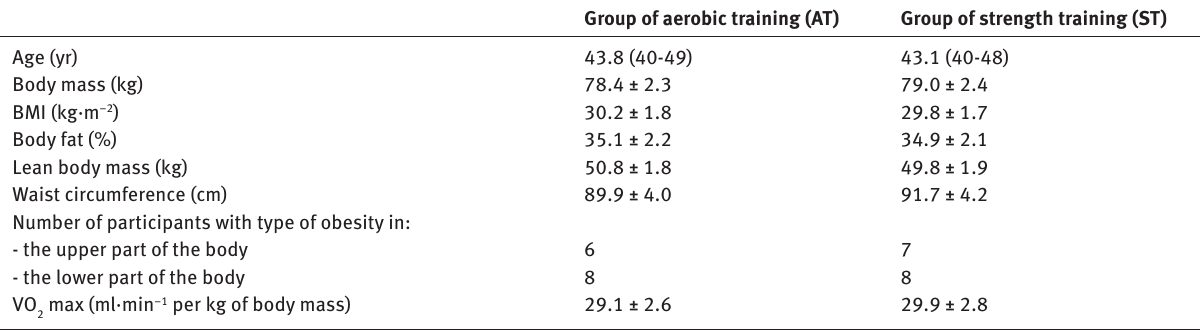
Table 1: Physical characteristics and maximum oxygen uptake of overweight females participating in health related physical training (mean ±